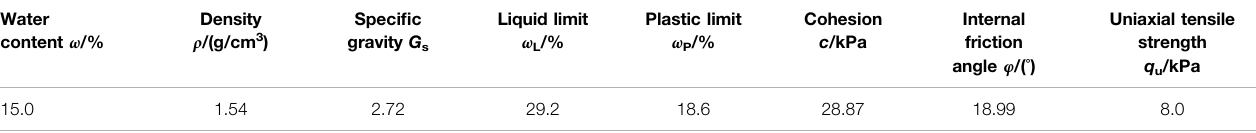
TABLE 1 | Physical and mechanical properties of soil in the study area.